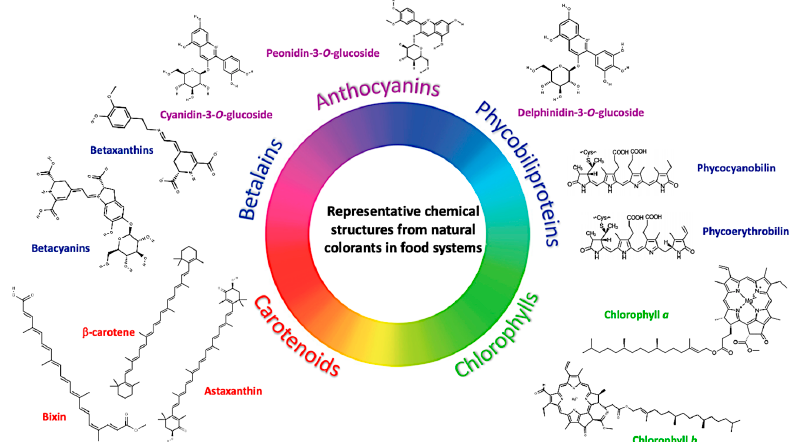
Figure 1. Representative chemical structures from the most common types of natural colorants applied in food systems. The chemical structures were downloaded from https://pubchem.ncbi.nlm.nih.gov (accessed on 21 February 2021). Chemical structures from phycobiliproteins were adapted from Hsieh-Lo et al. [16] with permission of Elsevier or applicable copyright owner.